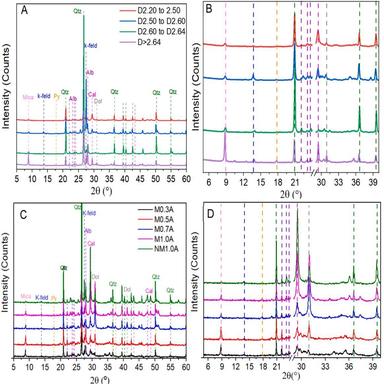
XRD data of recycled sands: density separation products at ranges of 2θ - 5–60º(A) and 2θ - 5–40º(B); and magnetic products at ranges of 2θ - 5–60º (C) and 2θ - 5–40º (D).